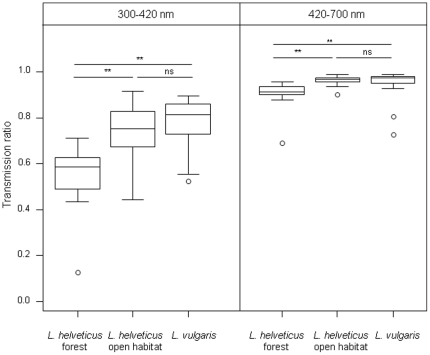
Terrestrial habitat and light transmission in water.Transmission spectra of water averaged over the 300–420 nm (UV) and 420–700 nm. Asterisks indicate p<0.01 with Mann-Whitney tests after checking for global significant differences between group using Kruskal-Wallis tests. ns = non significant, ** p<0.001.